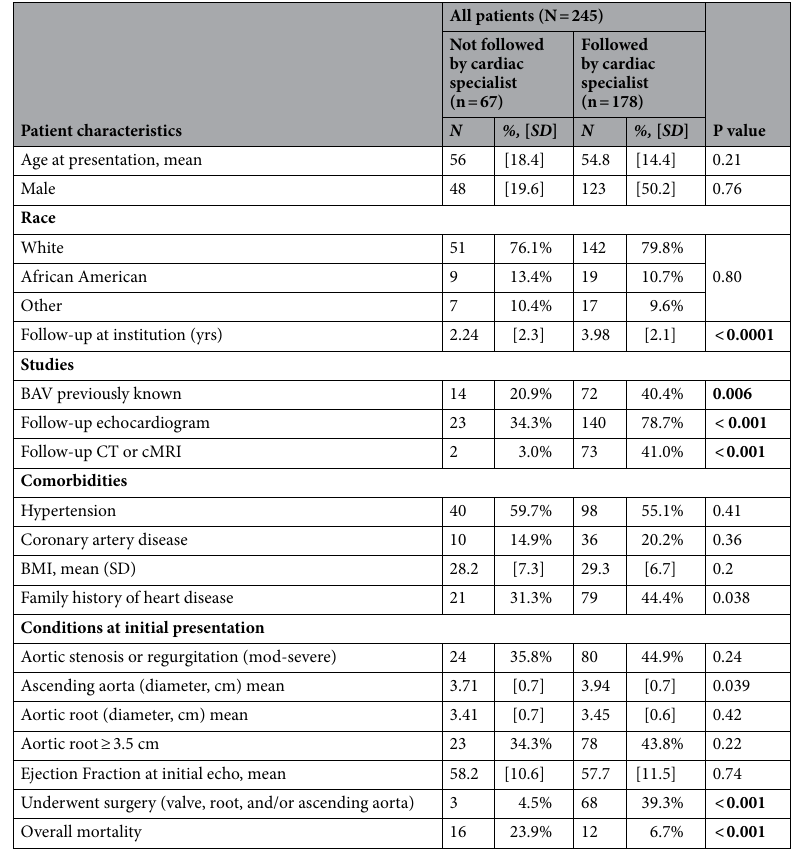
Table 1. Demographics of patients who received cardiology follow-up. BAV =bicuspid aortic valve, BMI =body mass index, CT =computerized tomography, echo =echocardiogram, cMRI =cardiac magnetic resonance imaging, SD =standard deviation, yrs =years. Significant values are in